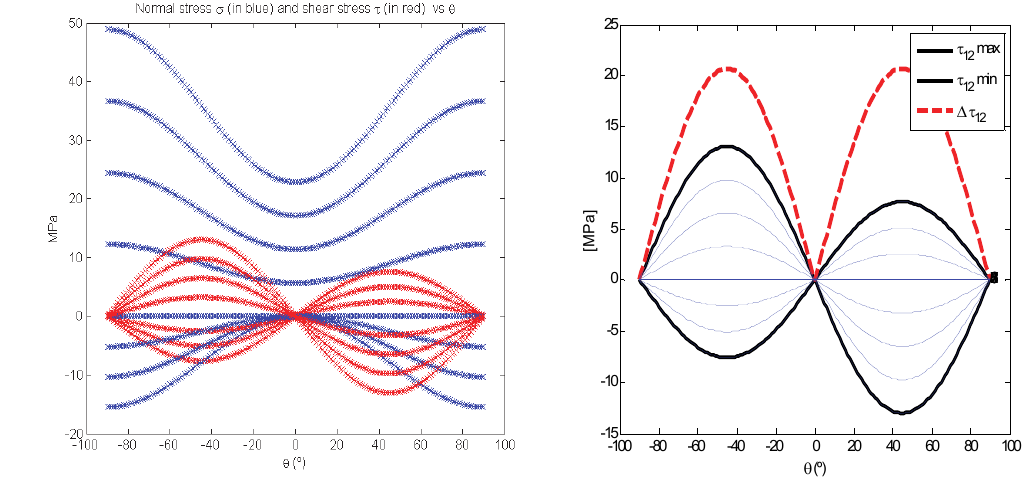
Figure 4: Left, variation of the normal stress  (in blue) and shear stress  (in red) on a plane forming an angle  with respect to the horizontal surface. Stresses are evaluated at the finite element located ahead the crack tip. Right, application of the min(  ) criterion.